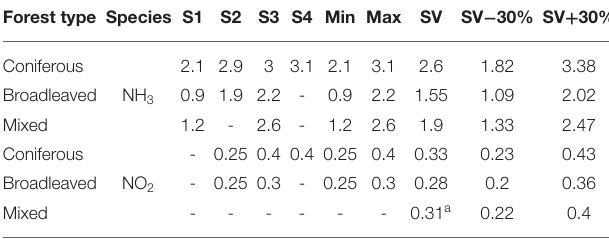
TABLE 2 | Deposition velocities for the inferential method (cm s − 1 ).